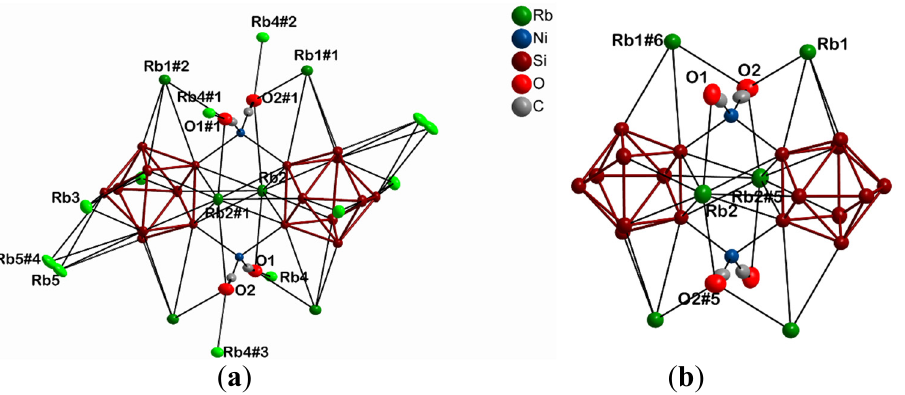
Figure 3. The comparison of the cation coordination of the complex anion [{Ni(CO) 2 } 2 (µ-Si 9 ) 2 ] 8 − in 1 ( a ) shows the presence of additional contacts (given in bright green) compared to the cation coordination of the complex anion [{Ni(CO) 2 } 2 (µ-Si 9 ) 2 ] 8 − in 2 ( b ). The position of Rb4 is mixedly occupied by rubidium and potassium (see text and Figure 3). Displacement ellipsoids are drawn at the 50% probability level.